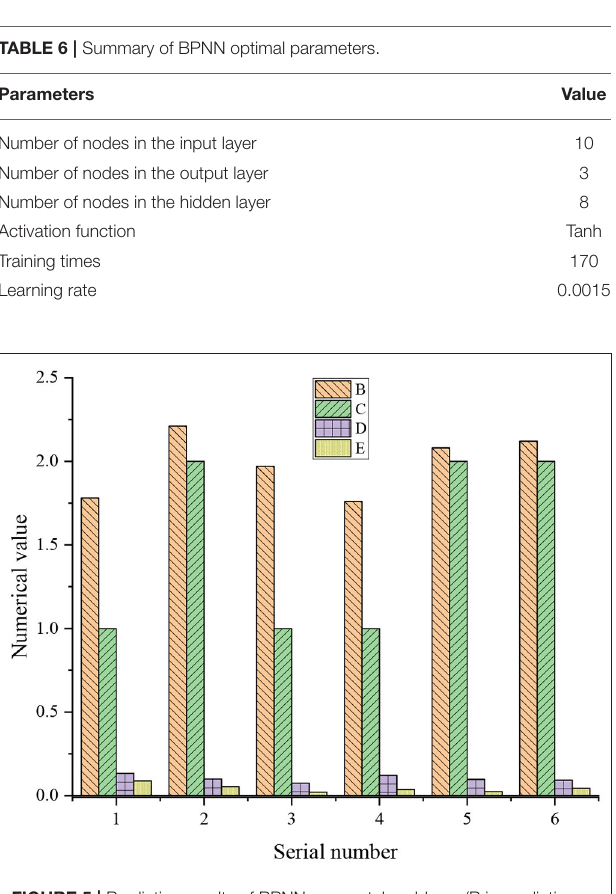
FIGURE 5 | Prediction results of BPNN on mental problems (B is prediction output, C is standard value, D is absolute error, and E is relative